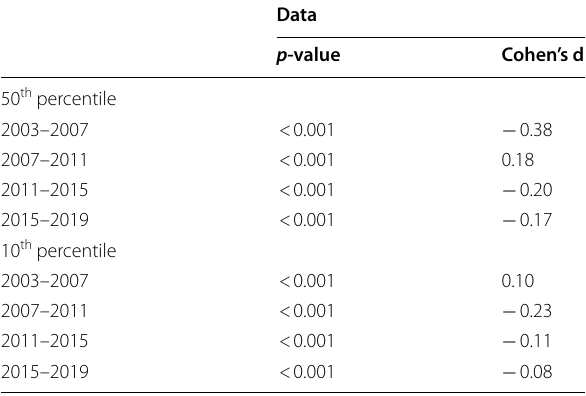
Table 2 Related to RQ3a, comparing cycle‑on‑cycle changes